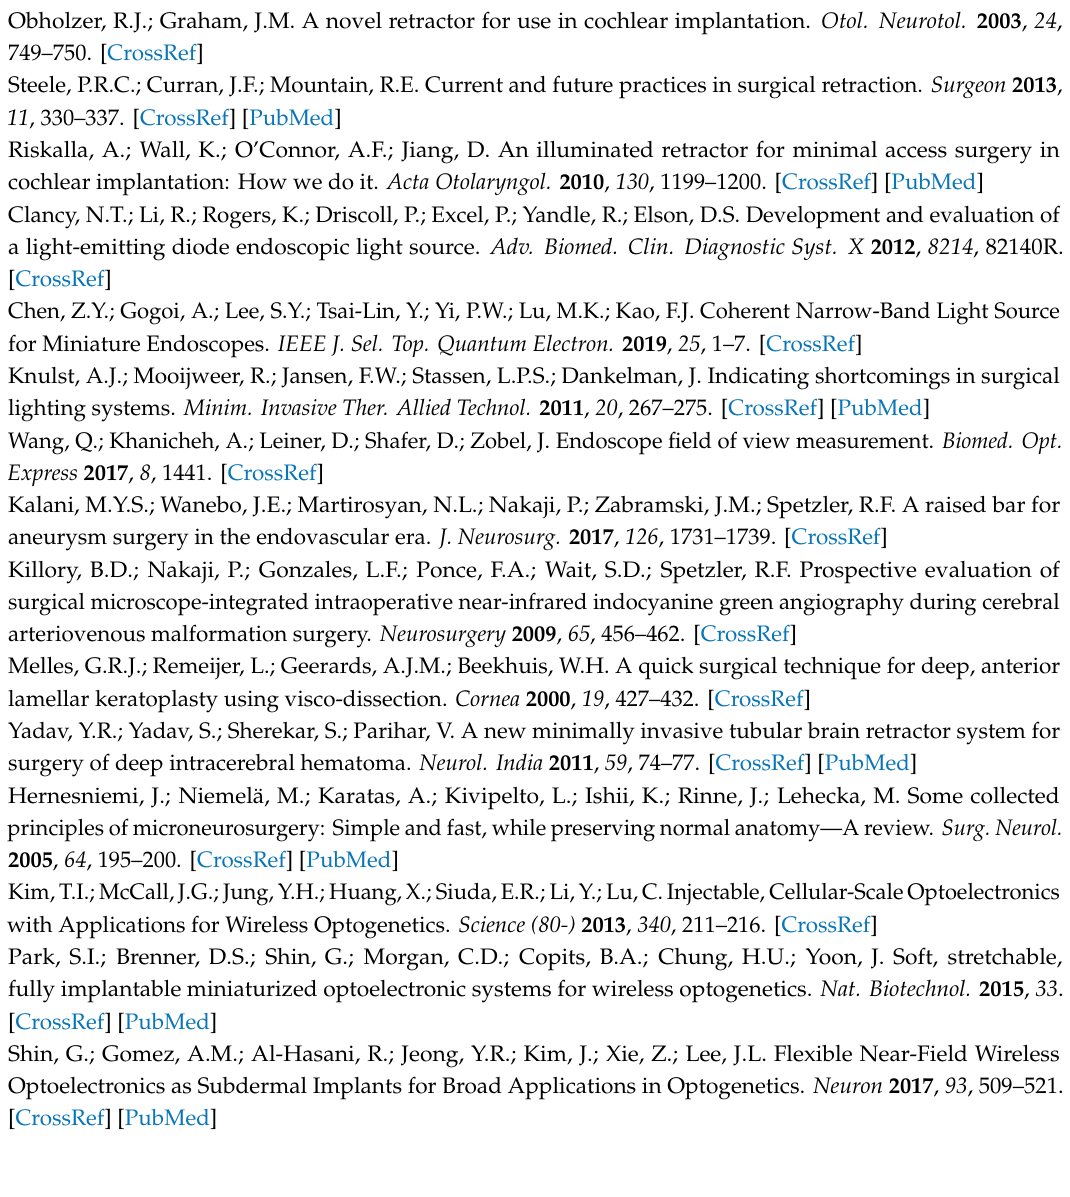
Figure S1: Device lay out and table of components, Video S1: Robust operation in dry condition, Video S2: Robust operation in wet